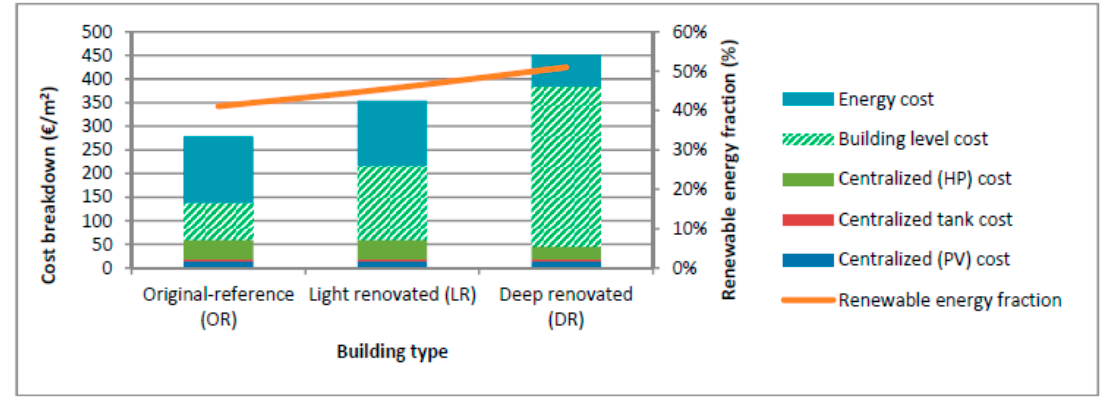
Figure 12. The breakdown of LCC of the old residential building community and the centralized PV + and A2WHP-based energy system (Case 2, PV + A2WHP). and A2WHP-based energy system (Case 2, PV